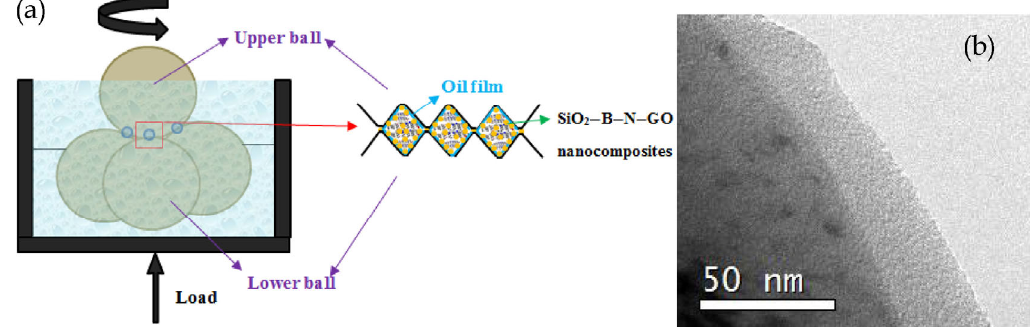
Fig. 10 (a) Schematic illustration of the lubrication of the four-balls using SiO 2 –B–N–GO nanocomposites and (b)TEM image of the tribofilm formed on the worn surface by the SiO 2 –B–N–GO